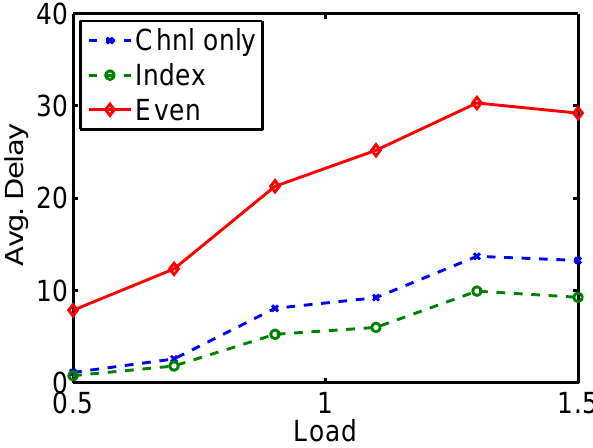
Figure 2. Average Delay when Index Policy Objective is Minimizing Average Delay, Real-life